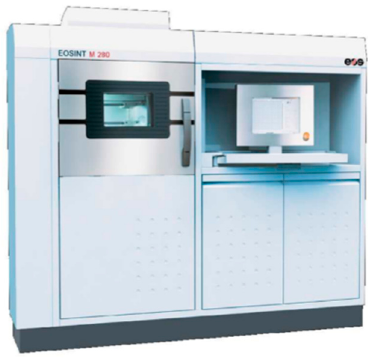
Figure 1. Machine EOSINT M280 [12].